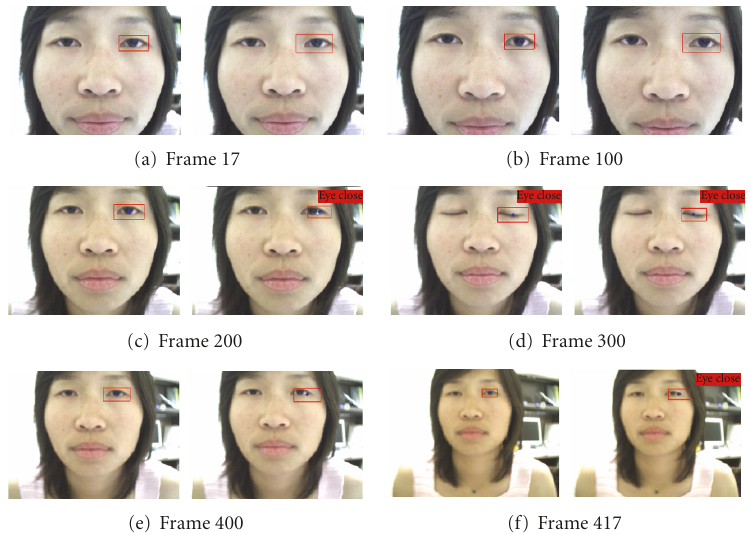
Figure 11: Comparison of using TSA subspace versus using tensorPCA subspace in observation models. In each subfigure, the left image shows the result from using TSA subspace, and the right one shows the result from using tensorPCA subspace.